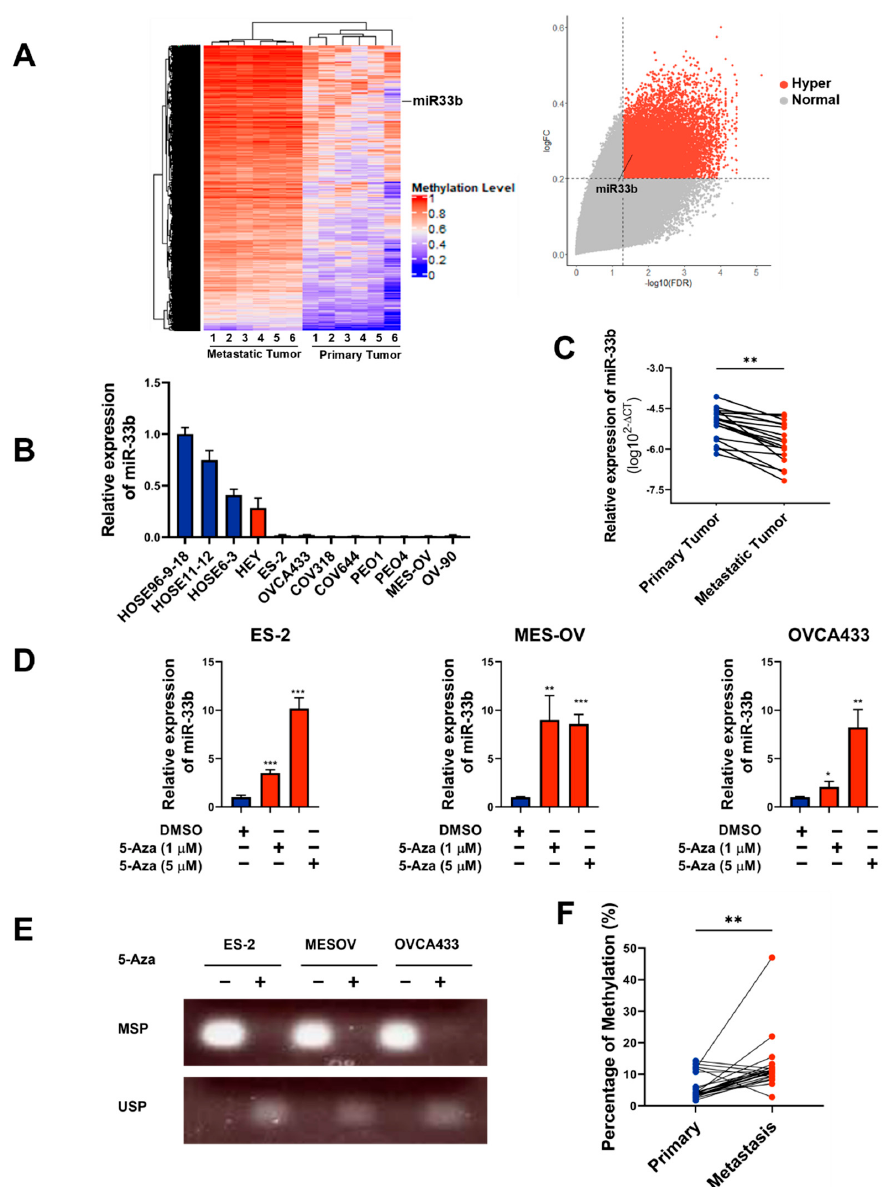
Figure 1. DNA methylation is associated with the downregulation of miR-33b in ovarian cancer. ( A ) DNA methylation was detected in six pairs of primary and metastatic tumors from ovarian cancer patients. Right panel: global DNA methylation. Left panel: significant differences in methylation level of miR-33b host gene. ( B ) qPCR analysis of miR-33b expression in human ovarian surface epithelial (HOSE) cell lines and ovarian cancer cell lines. U6 was used as an internal control. ( C ) MiR-33b expression level was measured in pairs of primary and metastatic ovarian tumors ( n = 18 pairs). ( D ) In ovarian cancer cells, the expression of miR-33b was restored upon treatment with 5-Aza-dc (1 μ M or 5 μ M) for 96 h. ( E ) DNA methylation of miR-33b promoter was assessed by MS-PCR in ovarian cancer cells upon 5-Aza-dC (5 μ M) treatment for 96 h. ( F ) Pyrosequencing analysis detected methylation percentage of miR-33b promoter in pairs of primary tumor tissues and omental specimens ( n = 22 pairs). Remarkable differences were observed in 18 pairs of ovarian cancer samples. Meanwhile, no significant difference was shown in the other 4 pairs of clinical tumor tissues. (* p < 0.05, ** p < 0.01, *** p < 0.001).